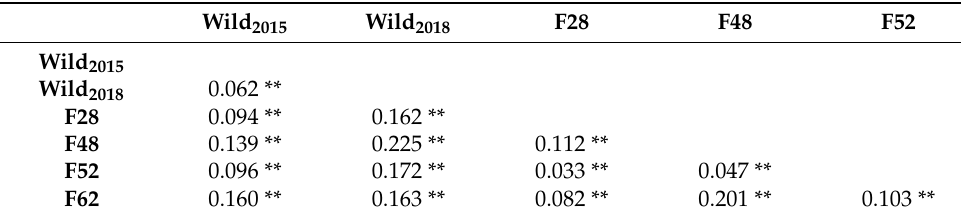
Table 2. Pairwise F ST estimates for wild and mass-reared cohorts of Hermetia illucens .